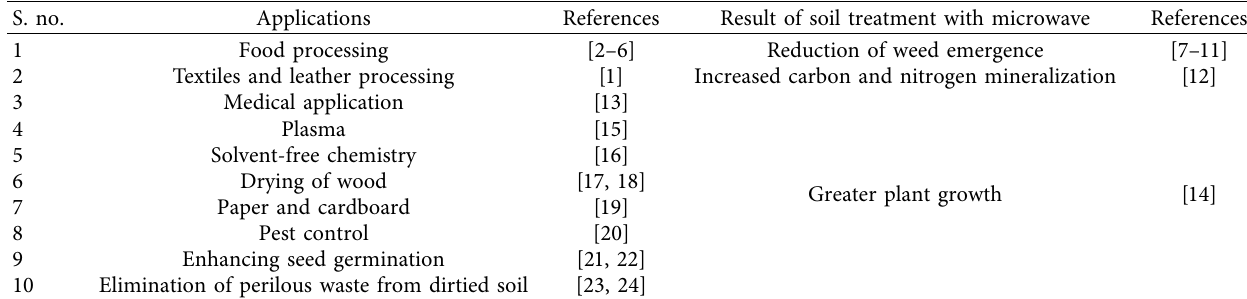
Table 1: Applications of microwave